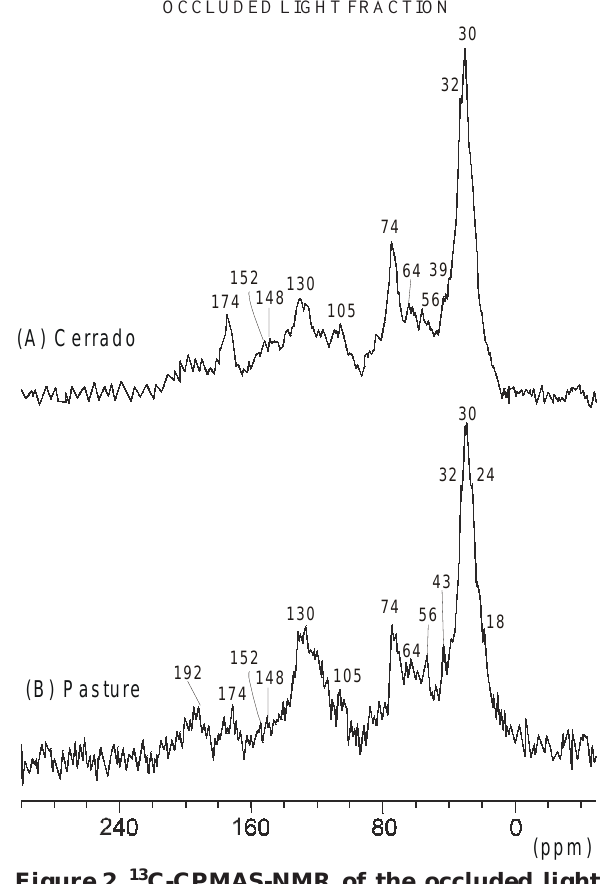
Figure 2. 13 C-CPMAS-NMR of the occluded light fraction (O-LF) of SOM from samples in the (A) cerrado and (B) pasture